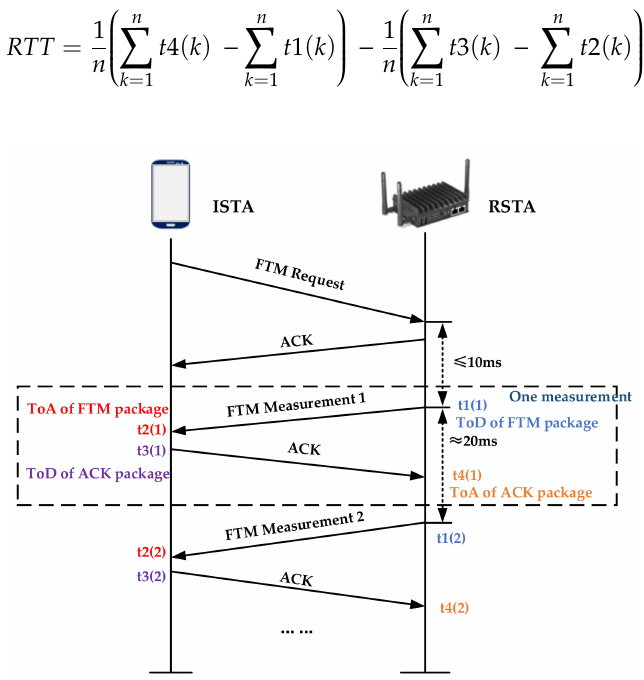
Figure 1. Schematic diagram of the ranging process of Wi-Fi fine time measurement (FTM).